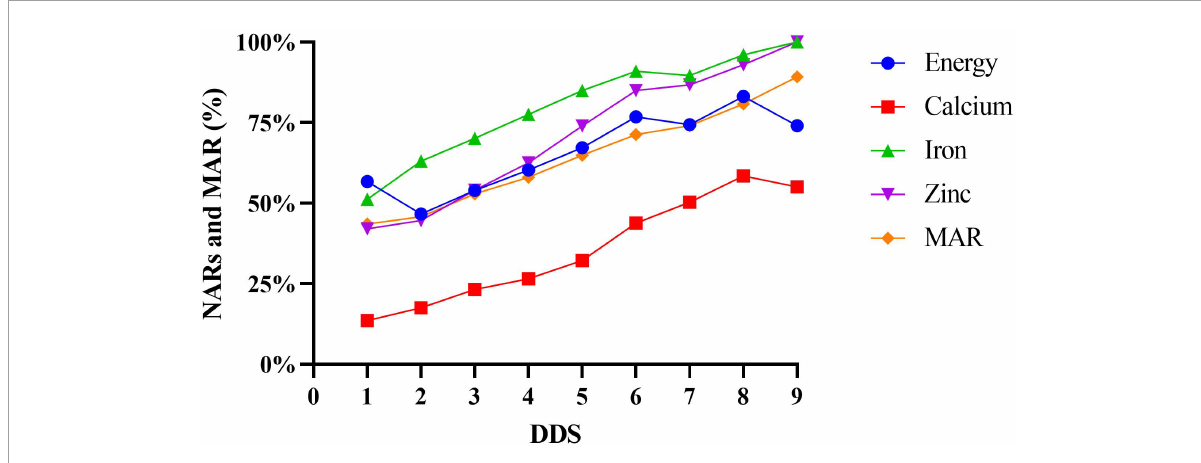
FIGURE3 NARs and MAR at different levels of dietary diversity score.